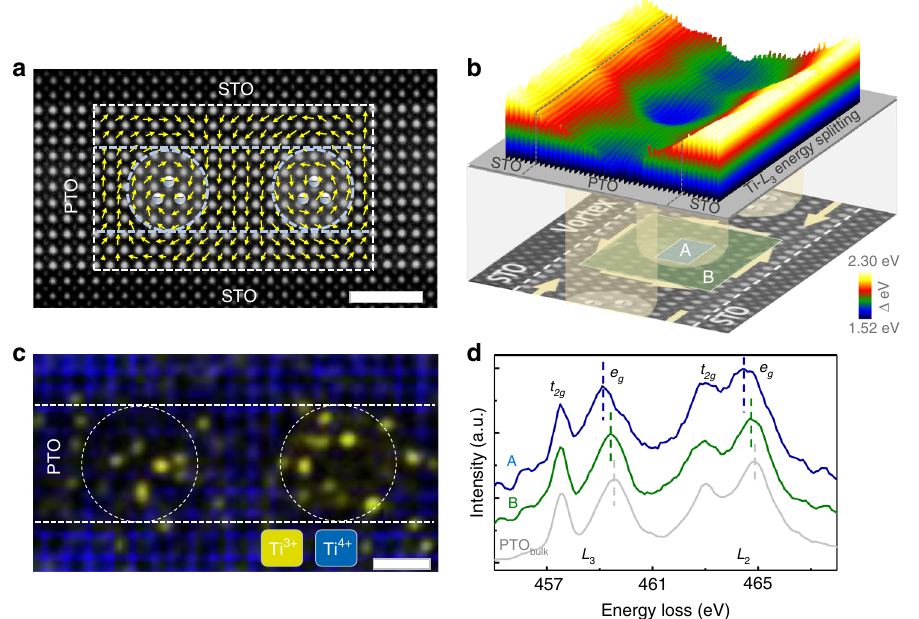
Fig. 3 EELS-mapping results in PTO (11) /STO (10) where vortex domains exist. a HAADF image of a PTO layer of 11 uc with vortex domains, together with its polar map. Dashed circles represent the concentrated areas of negative charge. Scale bar, 2 nm. b The upper colored surface plot shows the Ti – L 3 energy splitting in the PTO layer where a vortex exists, the lower HAADF image shows the location of the corresponding vortex structure in the PTO layer. c Superposition of the Ti 4 + and Ti 3 + signal based on EELS analysis; the investigated area is extracted from the dashed box area in a . Scale bar, 1 nm. d Ti – L 2, 3 spectra corresponding to three areas: the blue-A curve is from the vortex core, the green-B curve is from the PTO layer but away from the vortex cores, and the gray curve is the reference Ti- L 2,3 spectrum acquired in the bulk-PTO. These three areas show a distinct variation of the EELS spectrum, which is a clear indication of the valence changes of